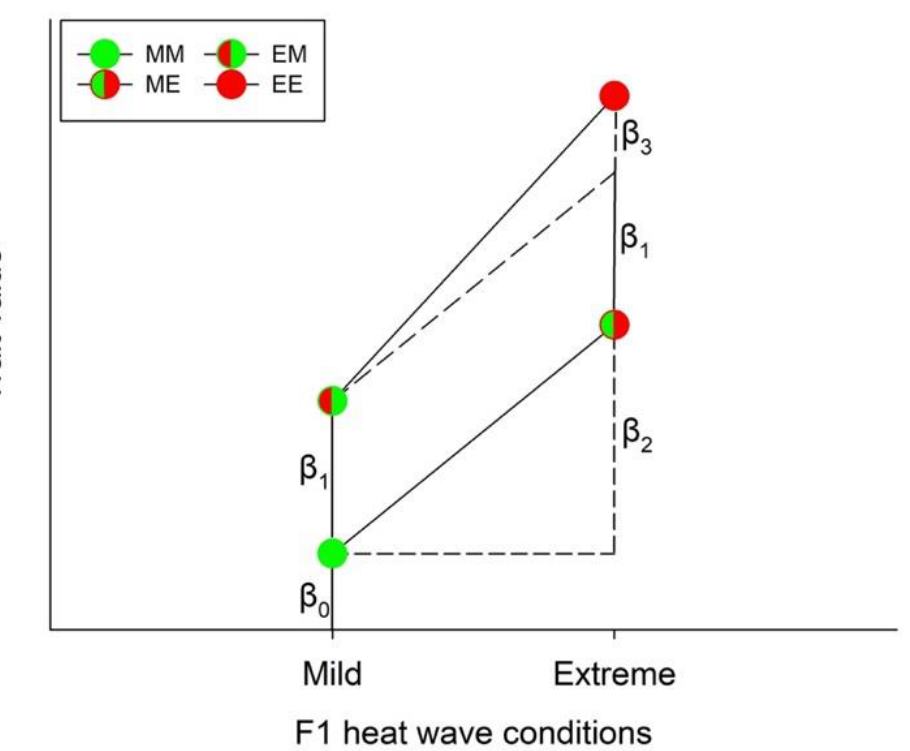
Figure 2. Schematic representation of the model used to analyze for potential plasticity types induced by heat waves (or other environmental stressors). The circles illustrate the different heat wave combinations. Each circle was divided into two halves: the left half marks whether the F0 generation was exposed to mild (green) or extreme (red) heat wave conditions, while the right half marks whether the offspring (F1) was exposed to mild (green) or extreme (red) heat wave conditions. β 0 is the model’s intercept (i.e., the expected trait value ( y ) when both F0 and F1 were exposed to mild heat waves, corresponding to F0 = F1 = 0 in Eqn 1). If only β 1 was significantly different from 0, it indicates a non-plastic trans-generational effect (TGE). A significant β 2 indicates a within-generational plastic response (WGP), while a significant β 3 indicates a trans-generational plastic response (TGP). Since the parameters can take both positive and negative values, the combined response to treatments will be largest if the parameters have the same sign and smallest if they differ with respect to sign.